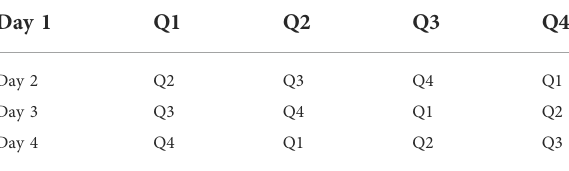
TABLE 1 Pattern of training trails on MWM test. (Q refers to quadrant). This table was adopted from our previous work (Kaur and Sodhi,